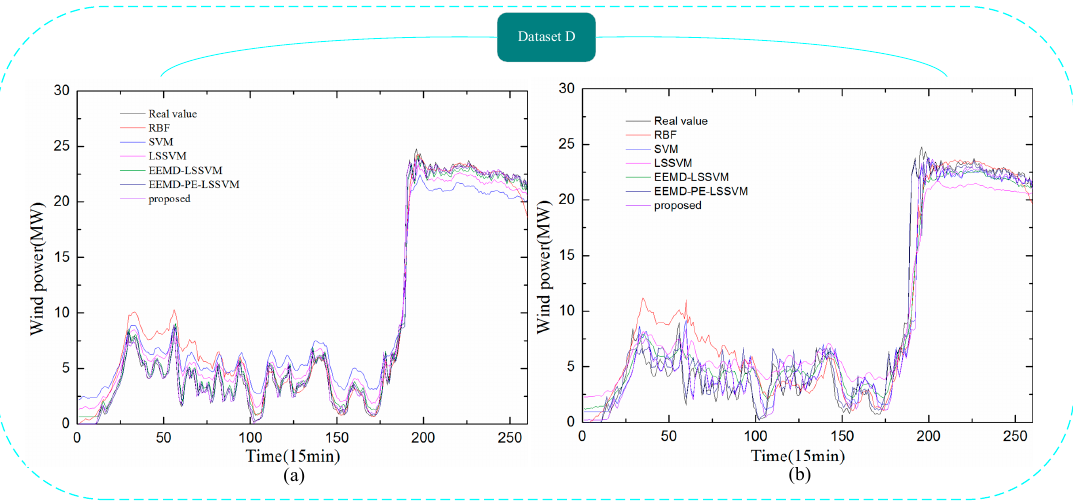
Figure 12. Comparison between the forecast and real values for Dataset D. ( a ) 1-step-ahead result; ( b ) 4-step-ahead result.